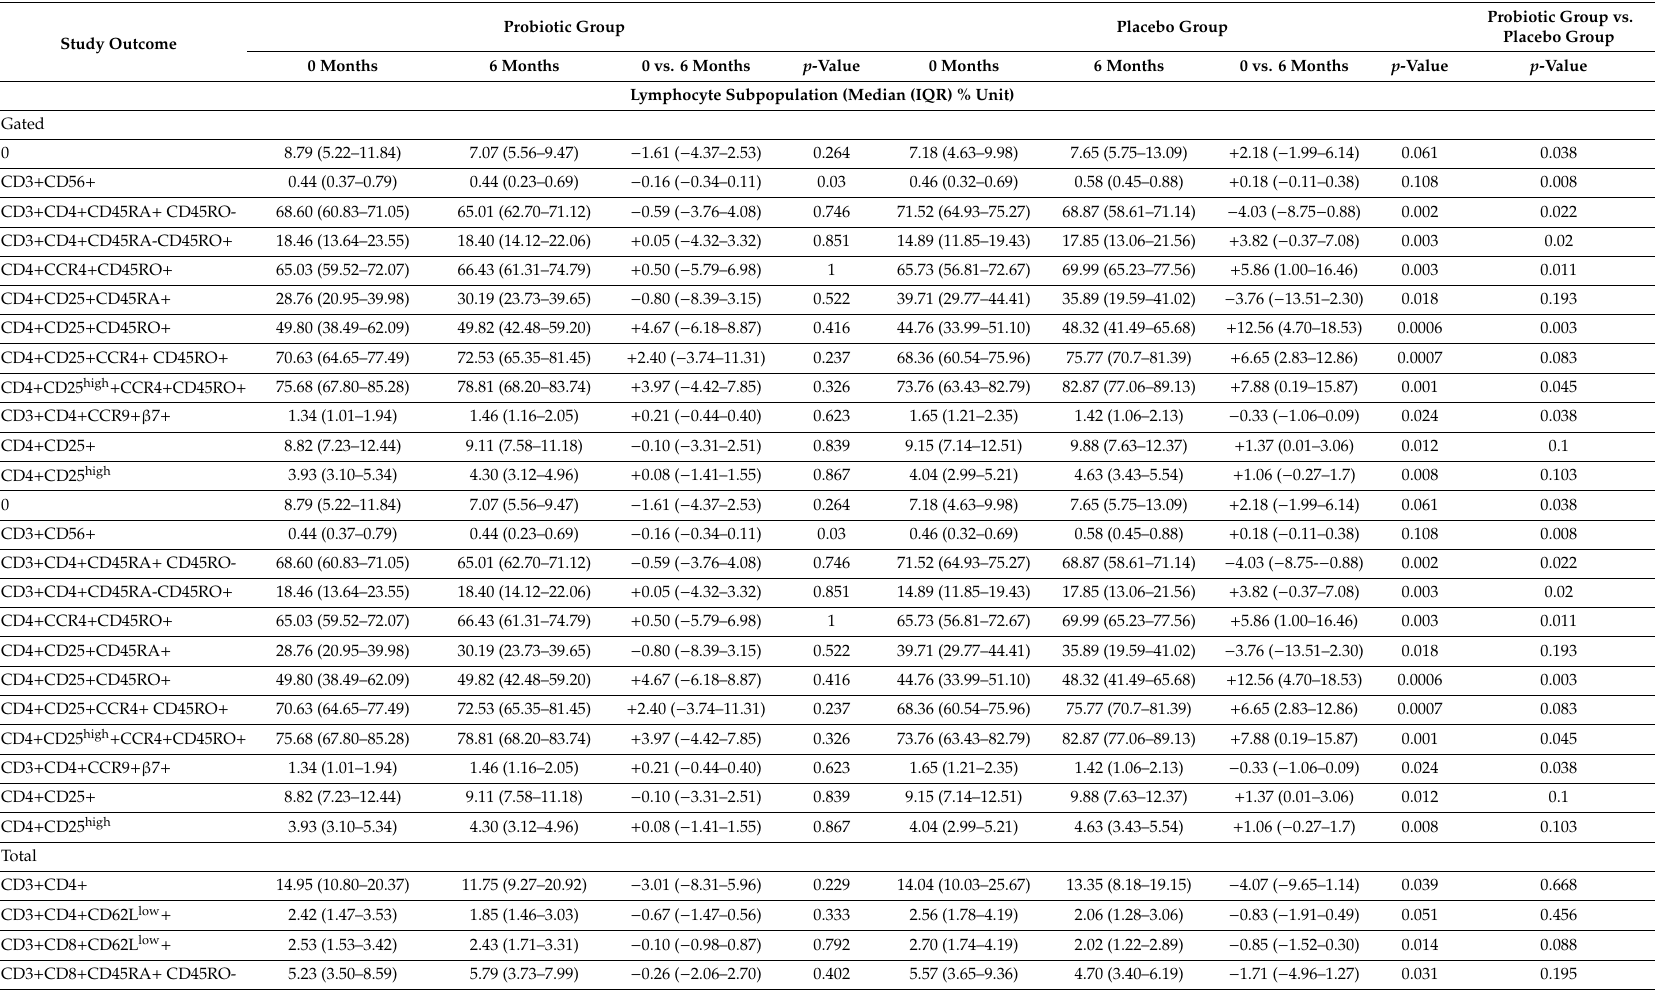
Table 3. Absolute changes in lymphocyte subsets within the groups and between groups after six months presented as median (IQR) percentage gated cells and median (IQR) percentage of total